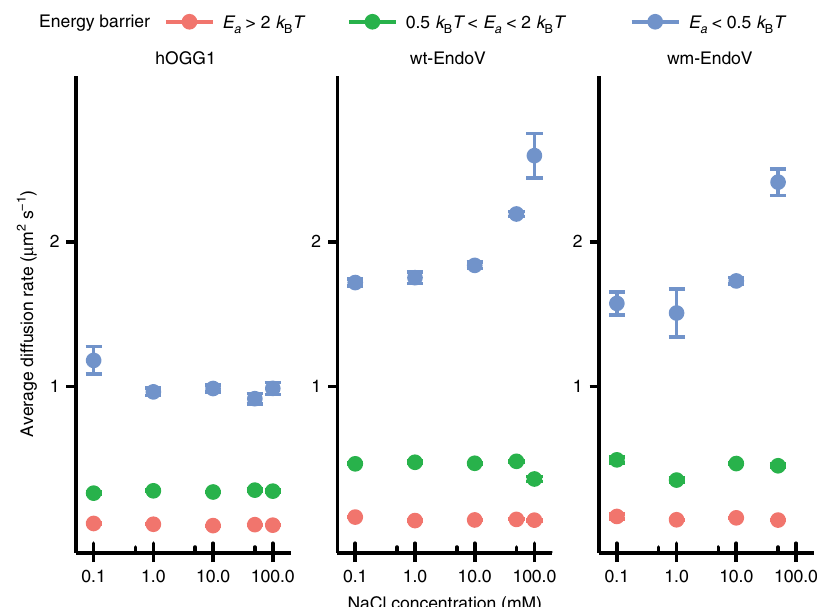
Fig. 3 Diffusion rate analysis by buffer salt concentration. Average diffusion rates for each mode of diffusion as a function of buffer salt concentration. Error bars show the standard error of the mean (SEM) and are not visible when smaller than the size of the points in the